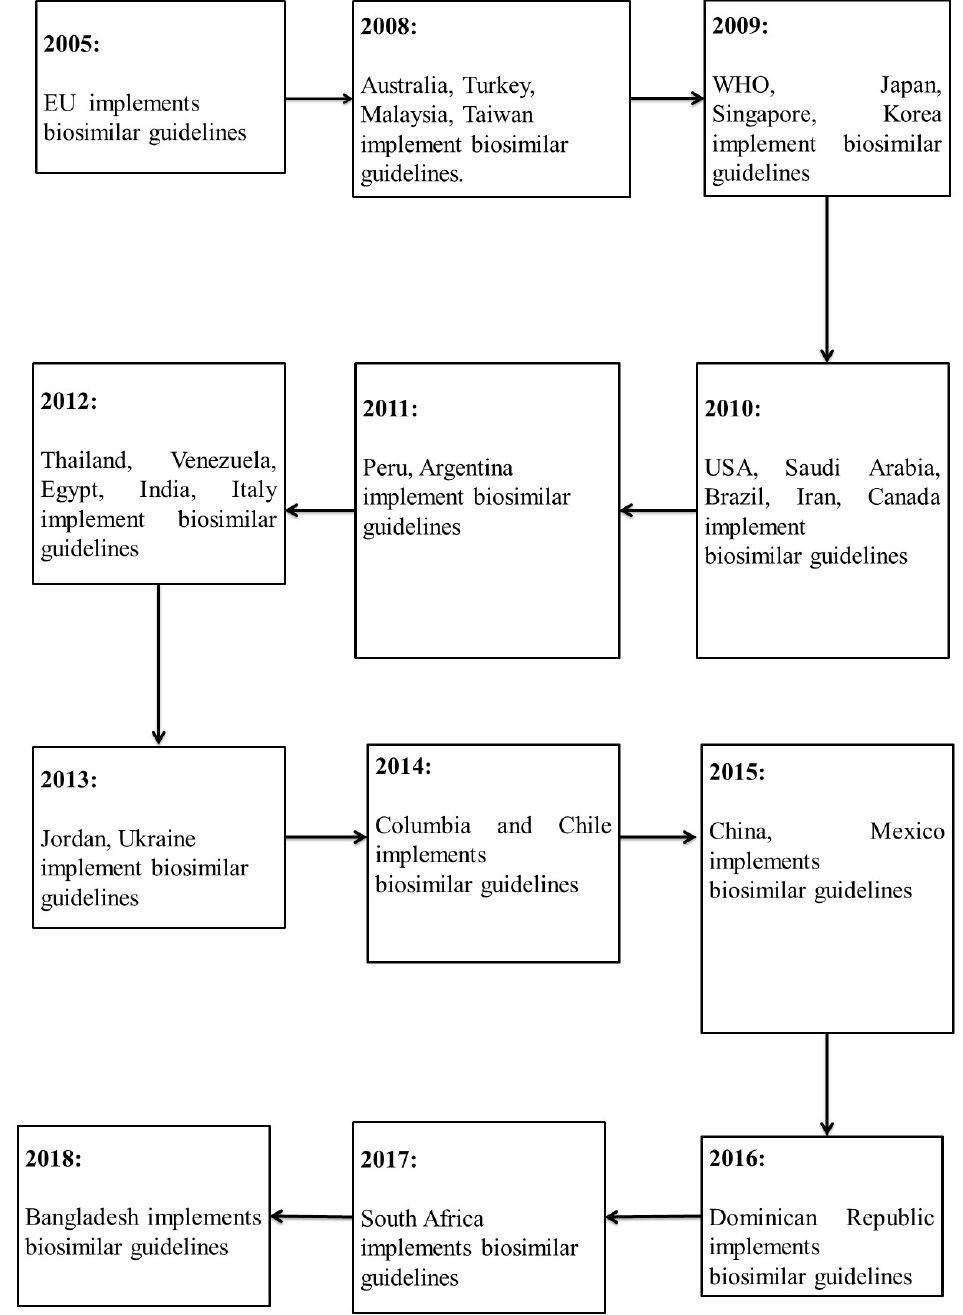
Figure 1. Progression of regulatory guidelines implementation for biosimilars from 2005 to